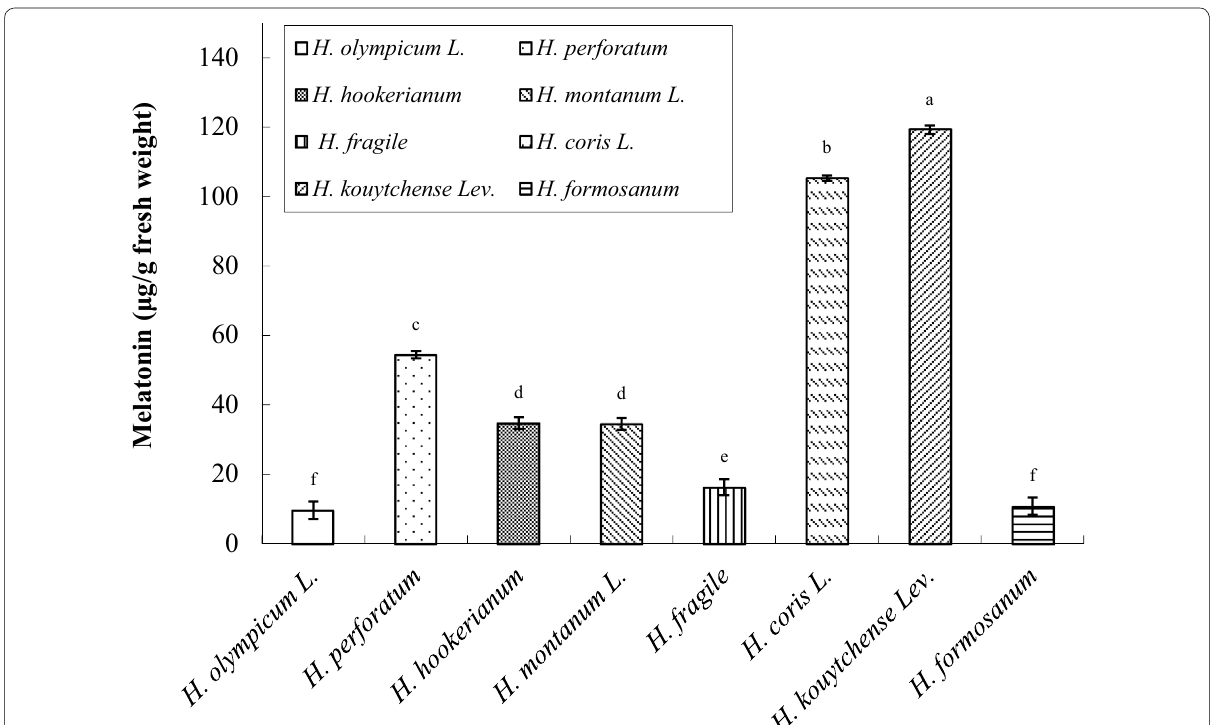
Fig. 6 Comparison of melatonin concentration in leaves of eight Hypericum spp. Data are the mean of three replicates, and different letters represent significant differences at p <